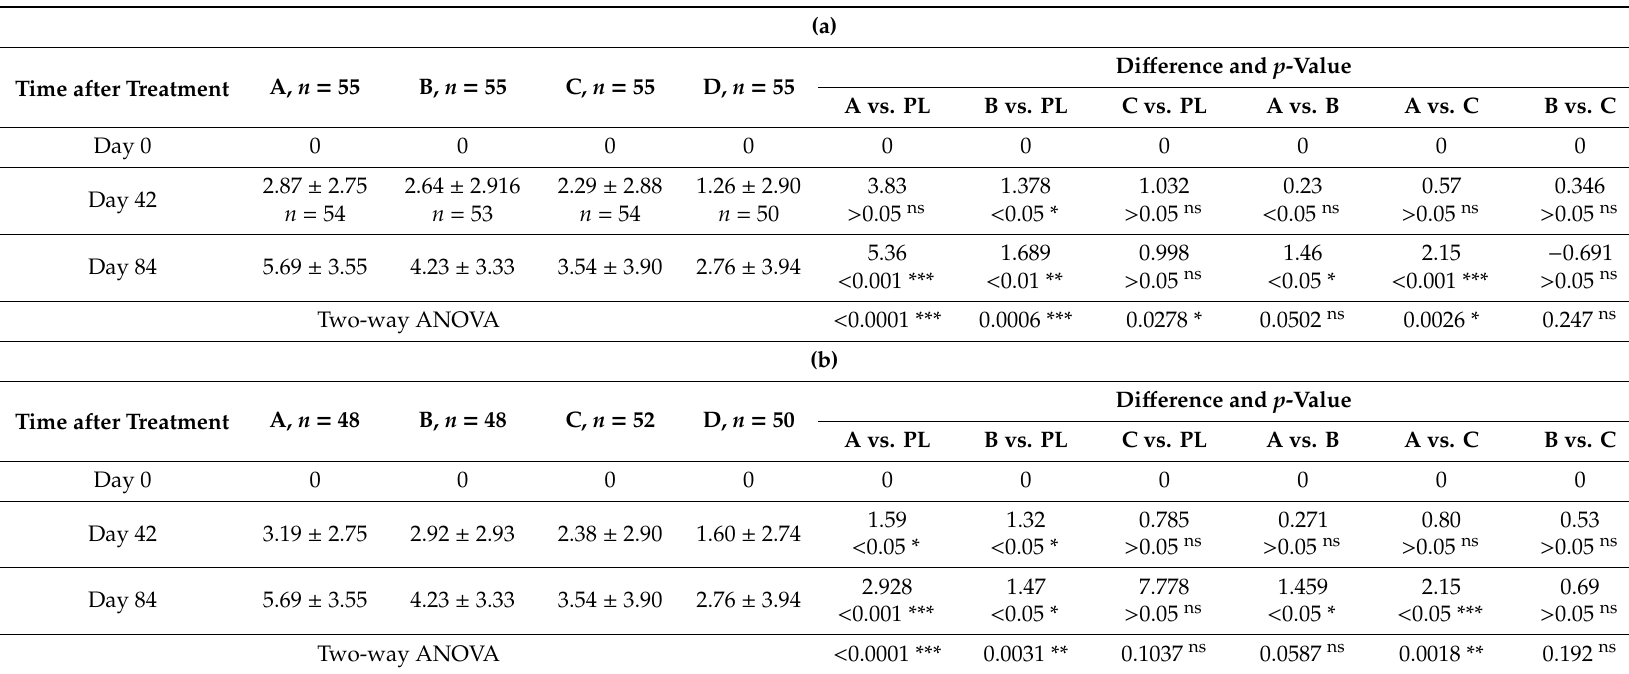
Table A5. ( a ). The change from baseline of UQOL physical health domain score (mean ± SD) over time. All patients including dropouts—ITT analysis. ( b ). The change from baseline of UQOL physical health domain score (mean ± SD) over time. Patients completed the treatment and all tests, dropouts